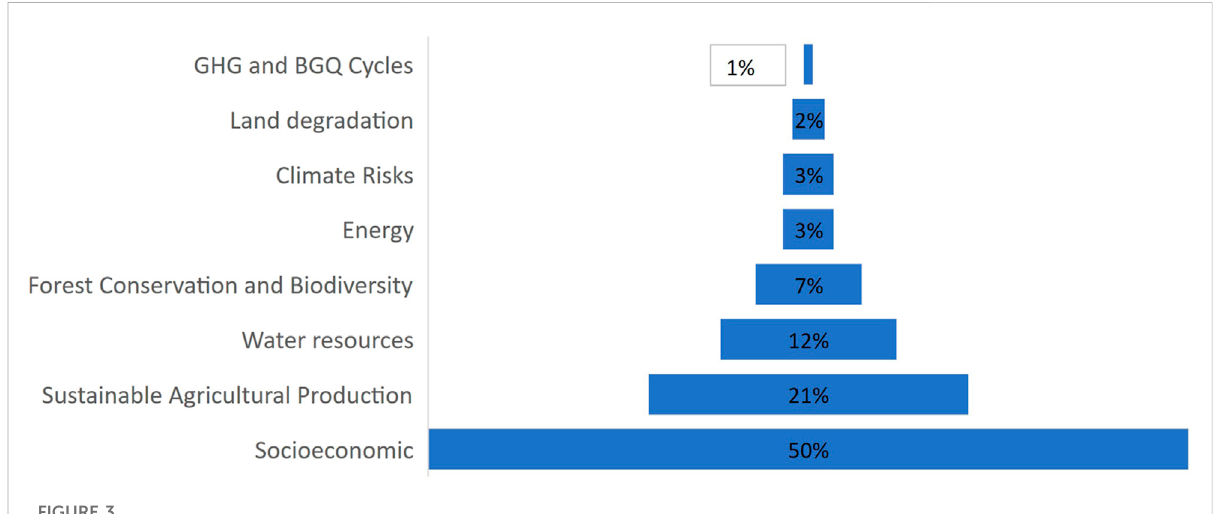
FIGURE 3 Construction indicator distribution according to Thematic Group Experts.